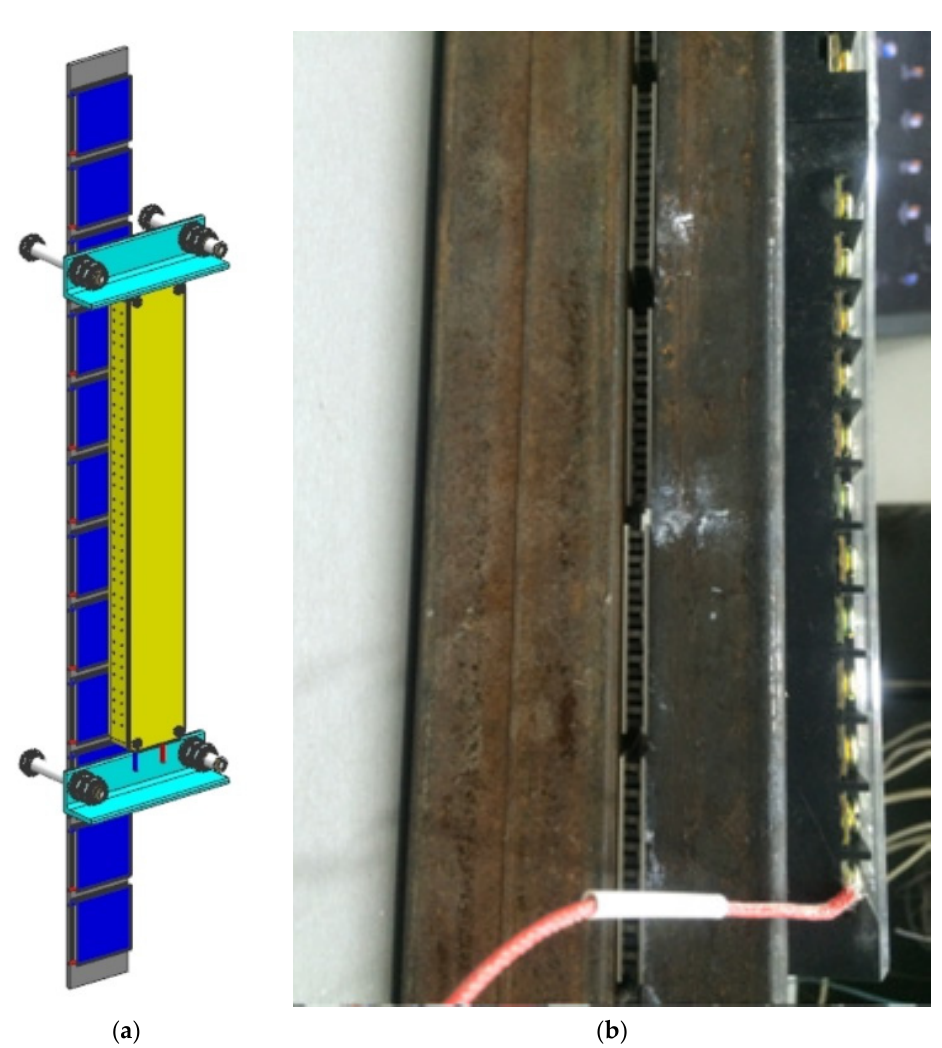
Figure 4. Installation of a heat sink for cooling thermoelectric modules: ( a ) scheme; ( b ) appearance. A general view of the thermoelectric converter and electrical connection of the ther- moelectric modules is presented in Figure 5.